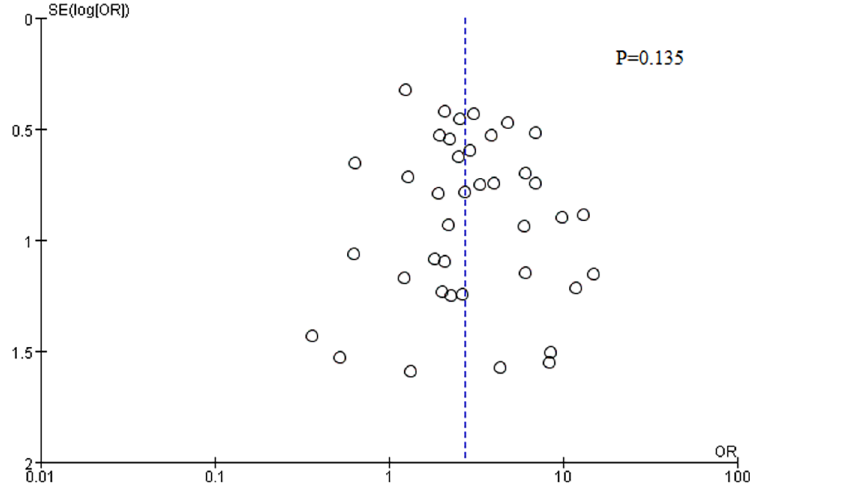
Fig 5. Funnel plot of publication bias.